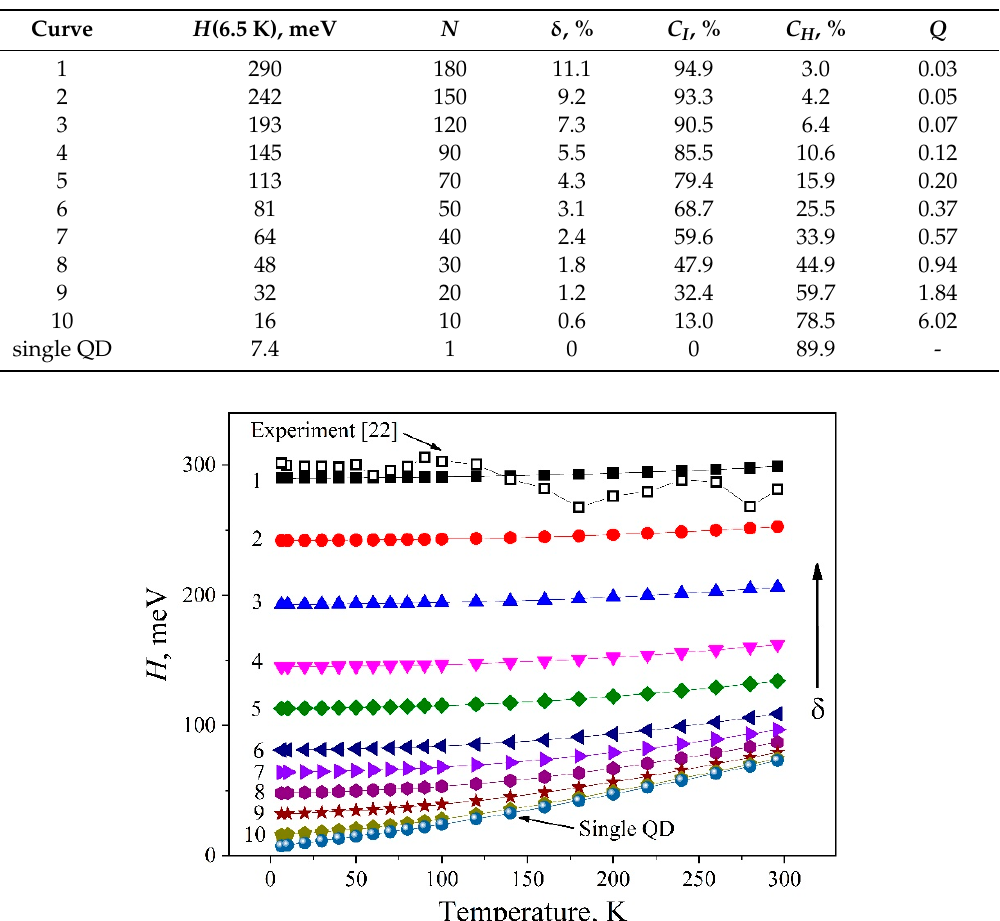
Table 2. Results of modeling the temperature behavior of exciton absorption band in InP / ZnS QD ensembles with di ff erent size distributions (data are shown on Figure 8).